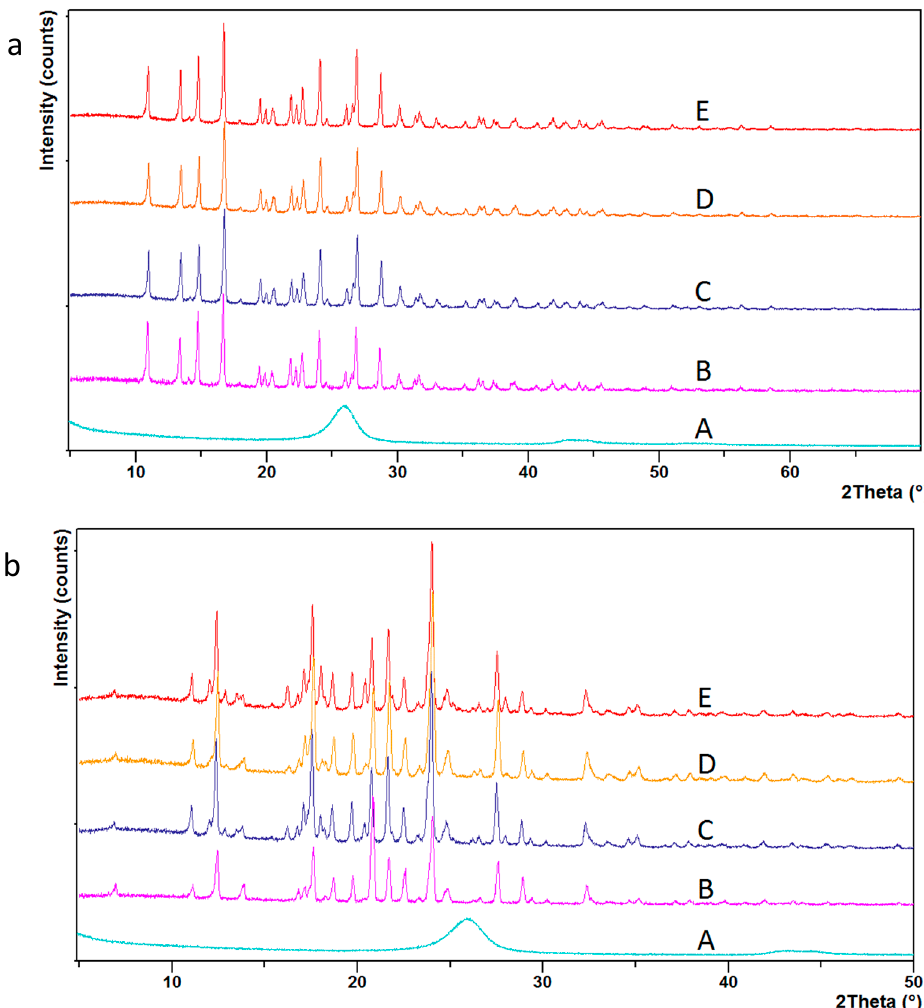
Figure 5. ( a ) X-Ray diffractometer (XRD) diffractogram of (A) f-CNT 23.2 , (B) pure GF, (C) GF-CNT 23.2 , (D) GF-CNT 19.8 , and (E) GF-CNT 16 ; ( b ) XRD diffractogram of (A) f-CNT 23.2 , (B) pure SMZ, (C) SMZ- CNT 23.2 , (D) SMZ-CNT 19.8 , and (E) SMZ-CNT 16 .